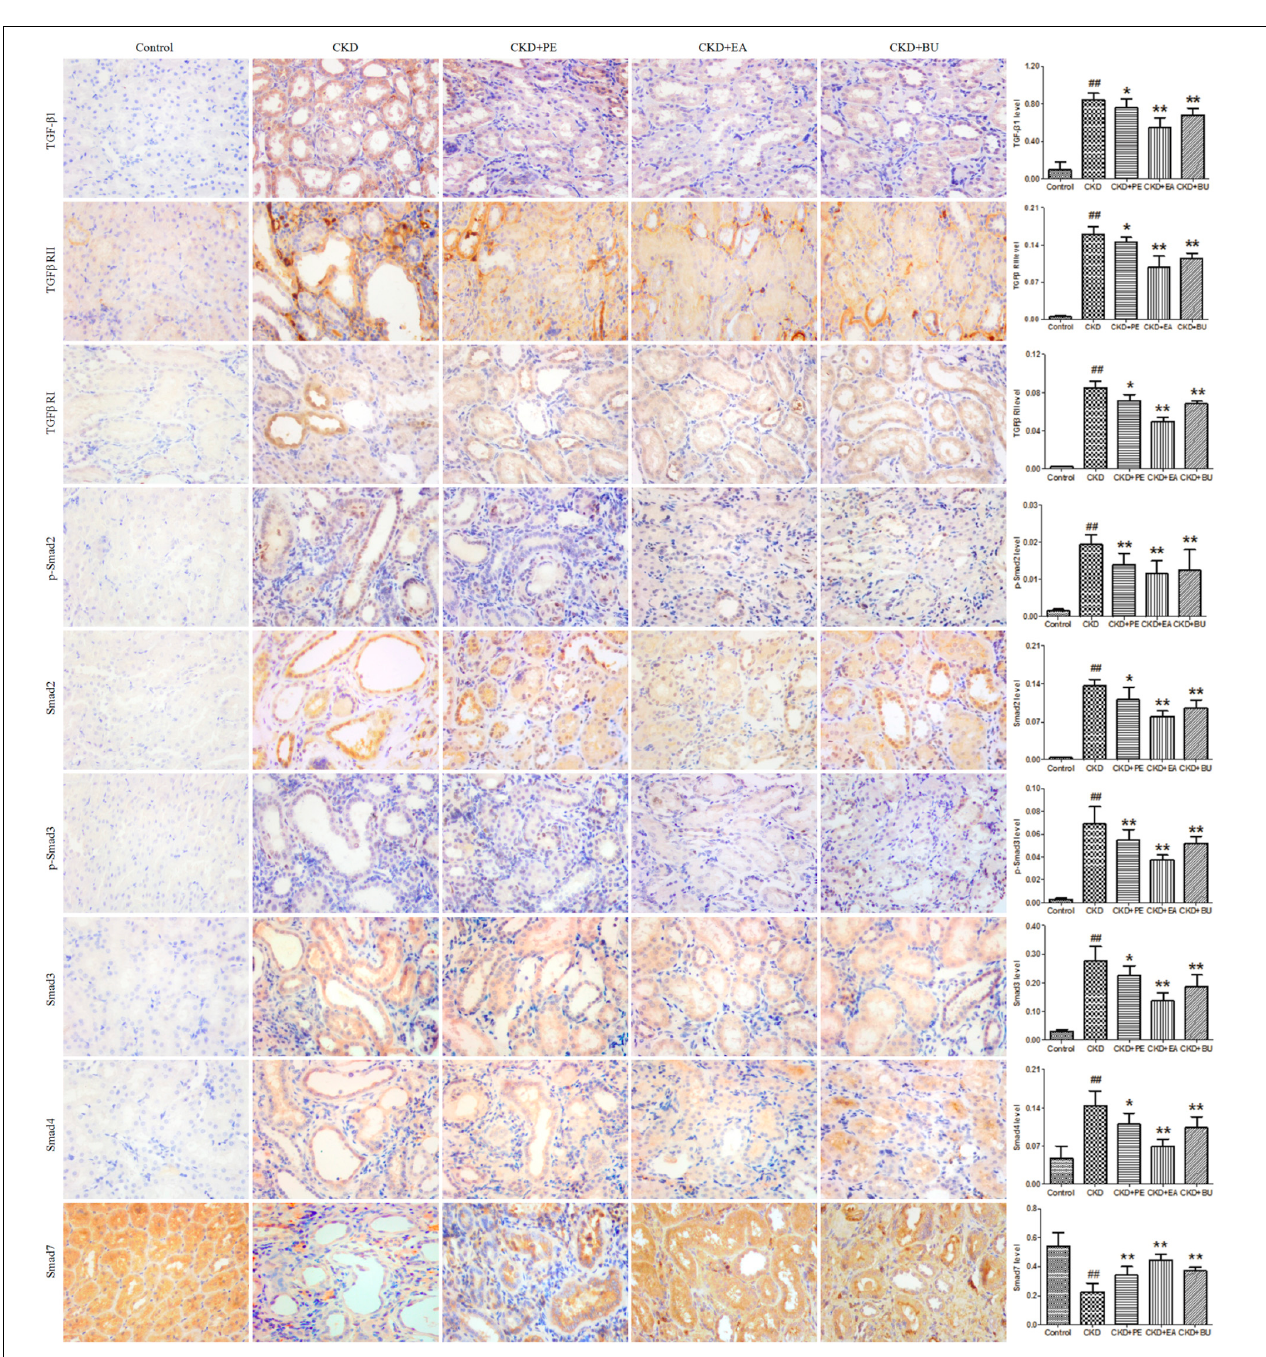
FIGURE 2 | Representative photomicrographs of the TGF- β 1, TGF- β RI, TGF- β RII, Smad2, p-Smad2, Smad3, p-Smad3, Smad4, and Smad7 immunohistochemistry from kidney sections in normal control rat, CKD rat, CKD+PE rat, CKD+EA rat, and CKD+BU rat. ## p < 0.01 compared to controls; ∗ p < 0.05, ∗∗ p < 0.01 compared to CKD